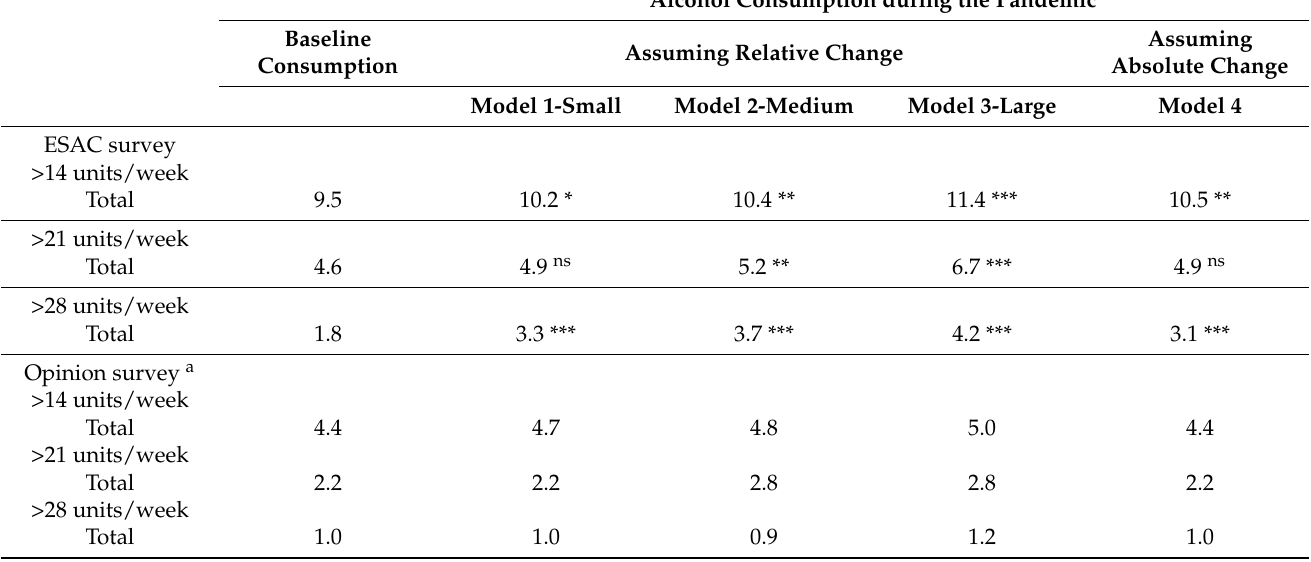
Table 3. Proportion of sample exceeding limits for risk drinking for baseline consumption and for estimated consumption during the pandemic by models—ESAC survey and Opinion survey. All values are given in percentage terms (%), n = 15,267/ n =